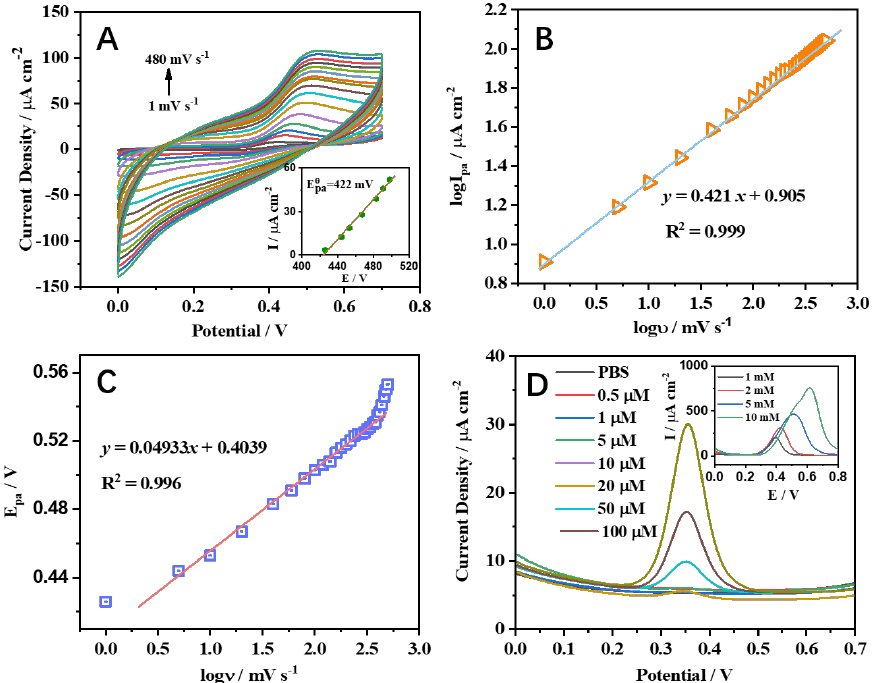
Figure 5. ( A ) CV curves at the clavate BiVO 4 electrode in 100 µ M paracetamol with different scan rates from 1 to 480 mV s − 1 . Inset of ( A ) is a plot of the peak current against peak potential with different scan rates. Dependence of ( B ) logυ− logI pa and ( C ) E p −logυ at the clavate BiVO 4 electrode. ( D ) DPV curves at clavate BiVO 4 electrode with the concretion of paracetamol from 0 to 100 µM. Inset of ( D ) shows DPV voltammograms corresponding to the high concentration of paracetamol with a 1 – 10 mM range.